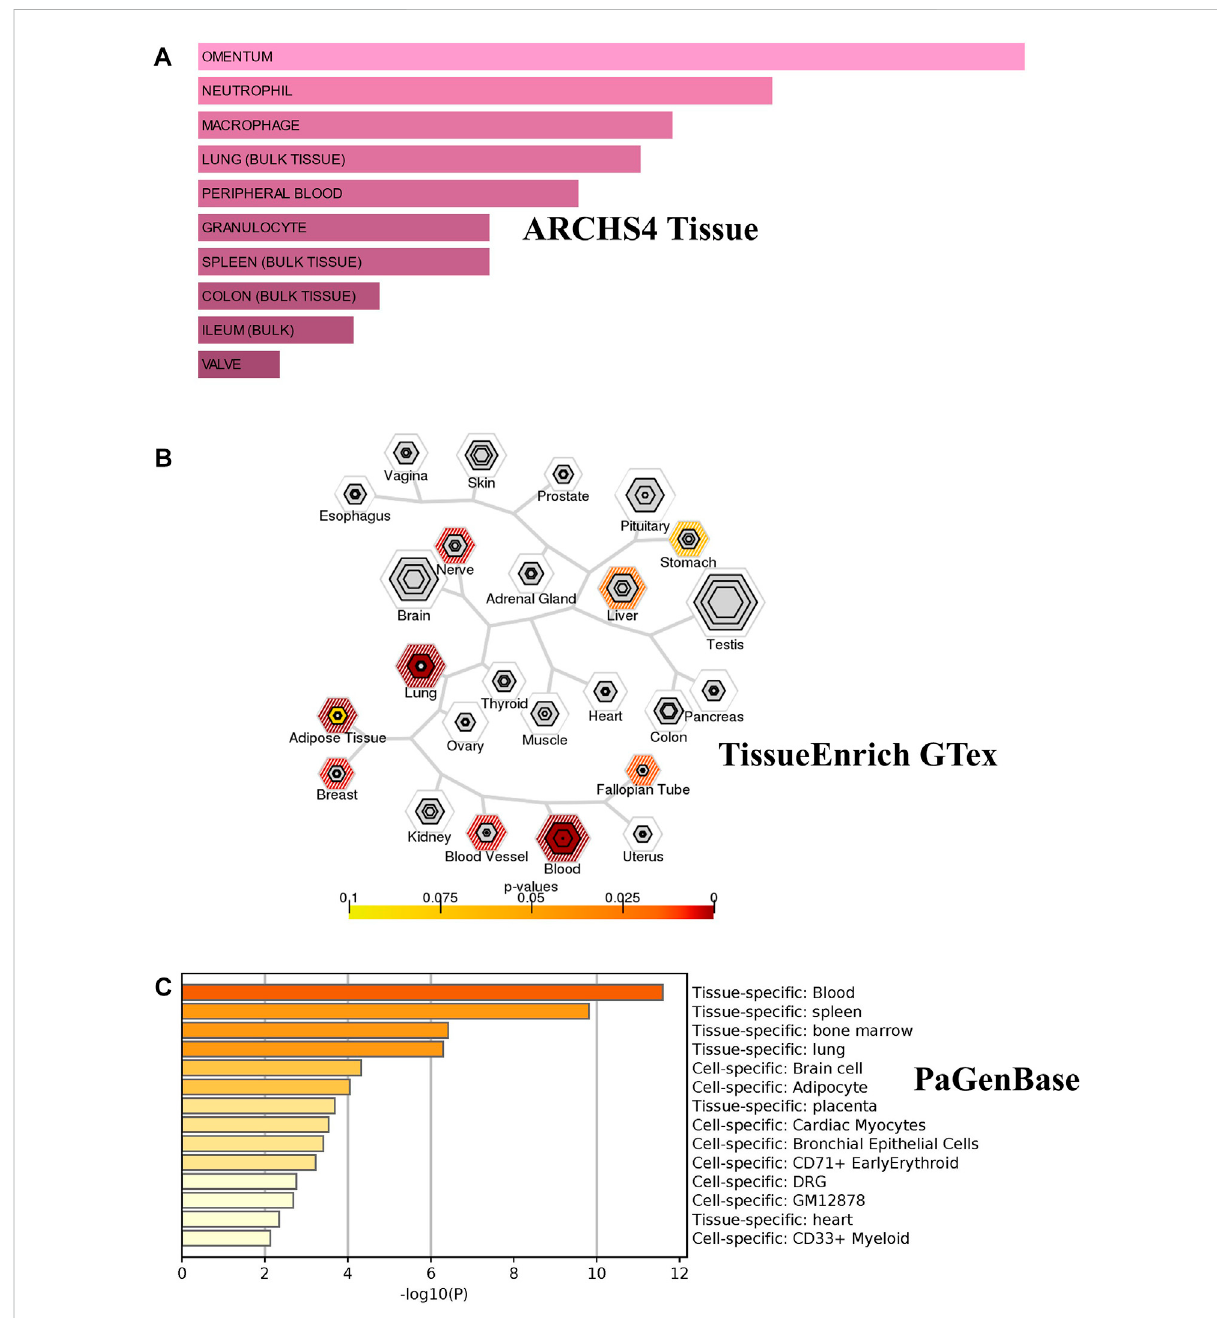
FIGURE 5 Tissue/cells-speci fi c enrichment of Shared comorbidities-COVID-19 genes. (A) Enrichr Bar Graph data were collected from Enricher web (https://amp.pharm.mssm.edu/Enrichr). The length of the bar represents the signi fi cance of that speci fi c gene-set or term. The brighter the color, themore signi fi cant that termis. (B) Tissue speci fi cexpression analysis(TSEA) network for common genes showing enrichmentfor genes expressed in related tissues. (C) Tissue/cell enrichment of the PaGenBase category of Metascape. The darker the color, the more signi fi cant that term is. Colored bars correspond to tissues with an adjusted p -value ≤